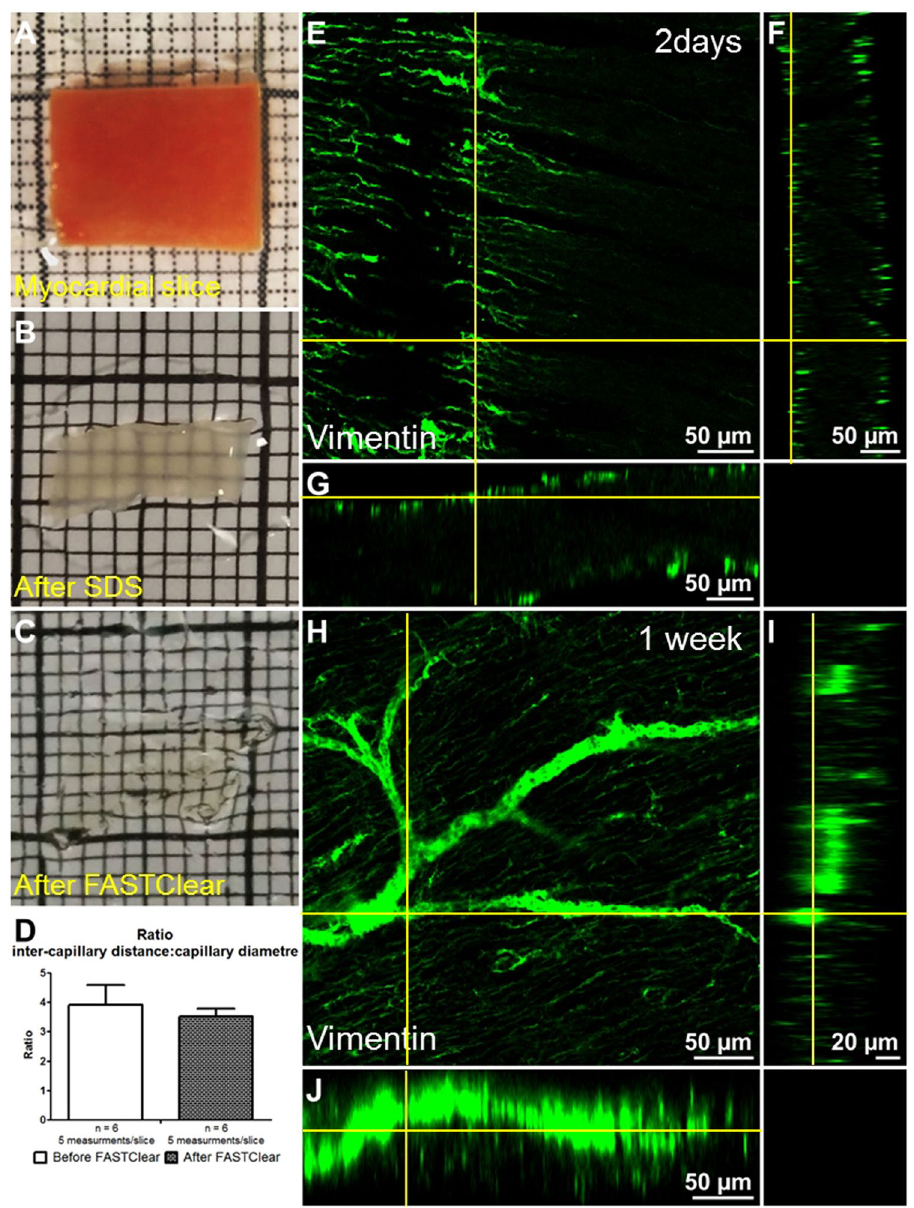
Figure 2. FASTClear provides an efficient myocardial tissue clearing protocol. ( A – C ) representative images of a myocardial slice before FASTClear, after SDS buffer treatment and after FASTClear protocol. ( D ) During tissue clearing the architecture and proportions of the myocardium is preserved and no changes in the inter-capillary distance to capillary diameter ratio were observed. Error bar = SEM. P > 0.05 T-test. ( E – G ) Orthogonal view of a myocardial slice after 48 hours antibody incubation, the labelling is limited to the surface of the preparation. ( H – J ) Orthogonal view of a myocardial slice after 1 week of antibody incubation. The labelling is homogeneously distributed and reached the core of the preparation. At least 3 slices were used for each